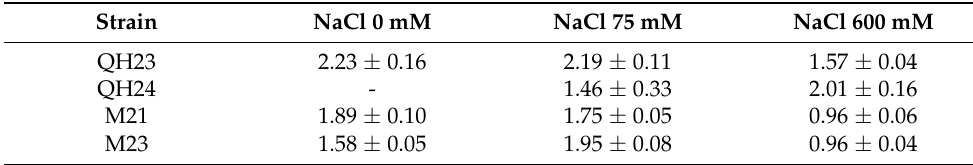
Table 3. IAA production without